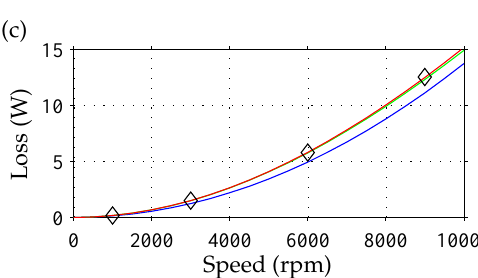
Figure 6. Predicted losses per magnet segment P m as a function of rotor speed and for different magnet lengths l m in V-shaped interior PMs ( w m = 15 mm) for Model A (blue line), Model B (red line), Model C (green line), and corresponding 3D-FEM results (diamonds “ ( c ) l m = 100 mm.